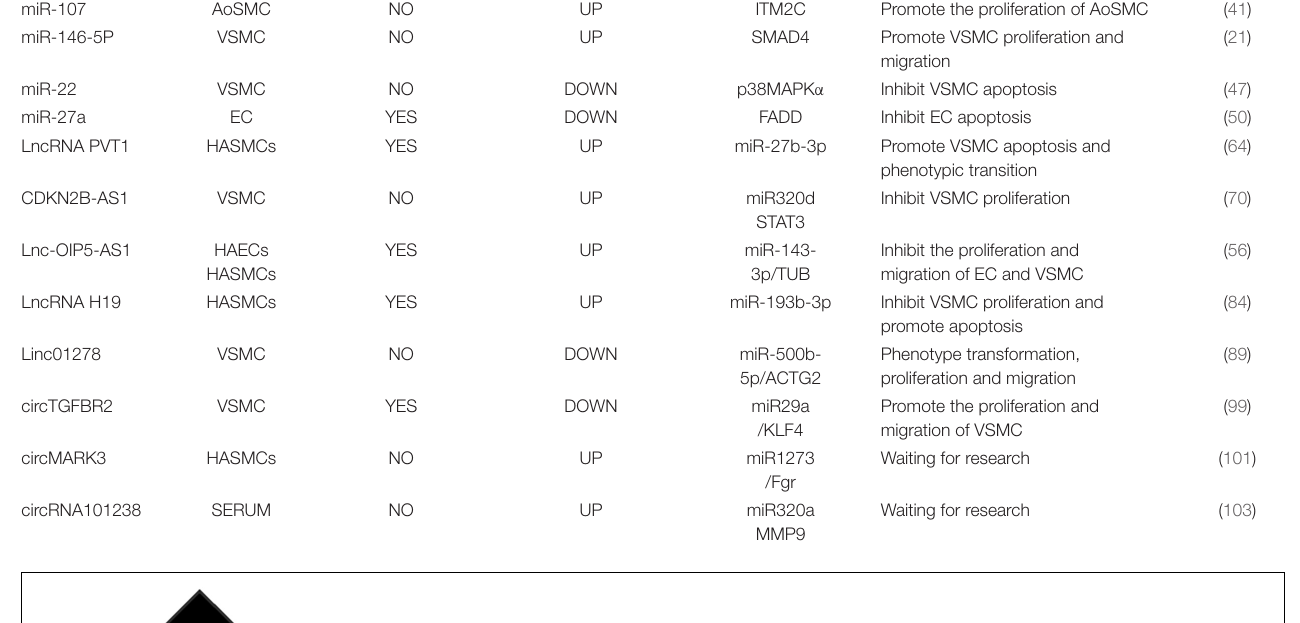
TABLE 1 | Selected ncRNAs implicated in aortic dissection.